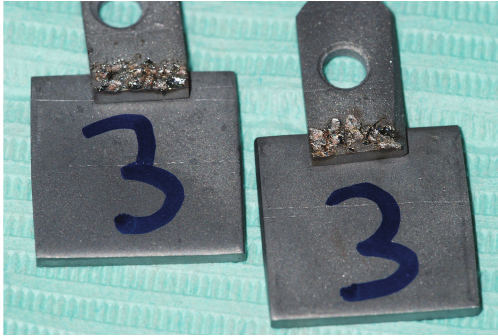
Figure 4: Plates of group C soldered by the